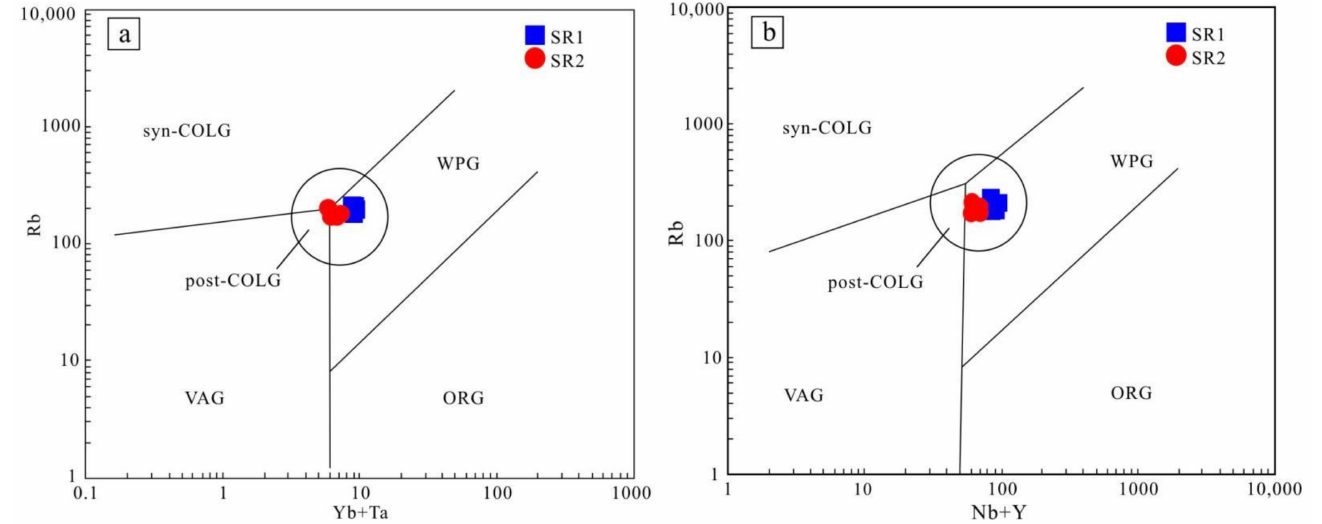
Figure 12. Tectonic environment discrimination diagram: ( a ) Yb-Ta diagram; ( b ) Y + Nb-Rb diagram (base drawing according to [103]). VAG: volcanic arc granite; ORG: ridge granite; WPG: intraplate granite; syn-COLG: collisional granite; post-COLG = post-collisional